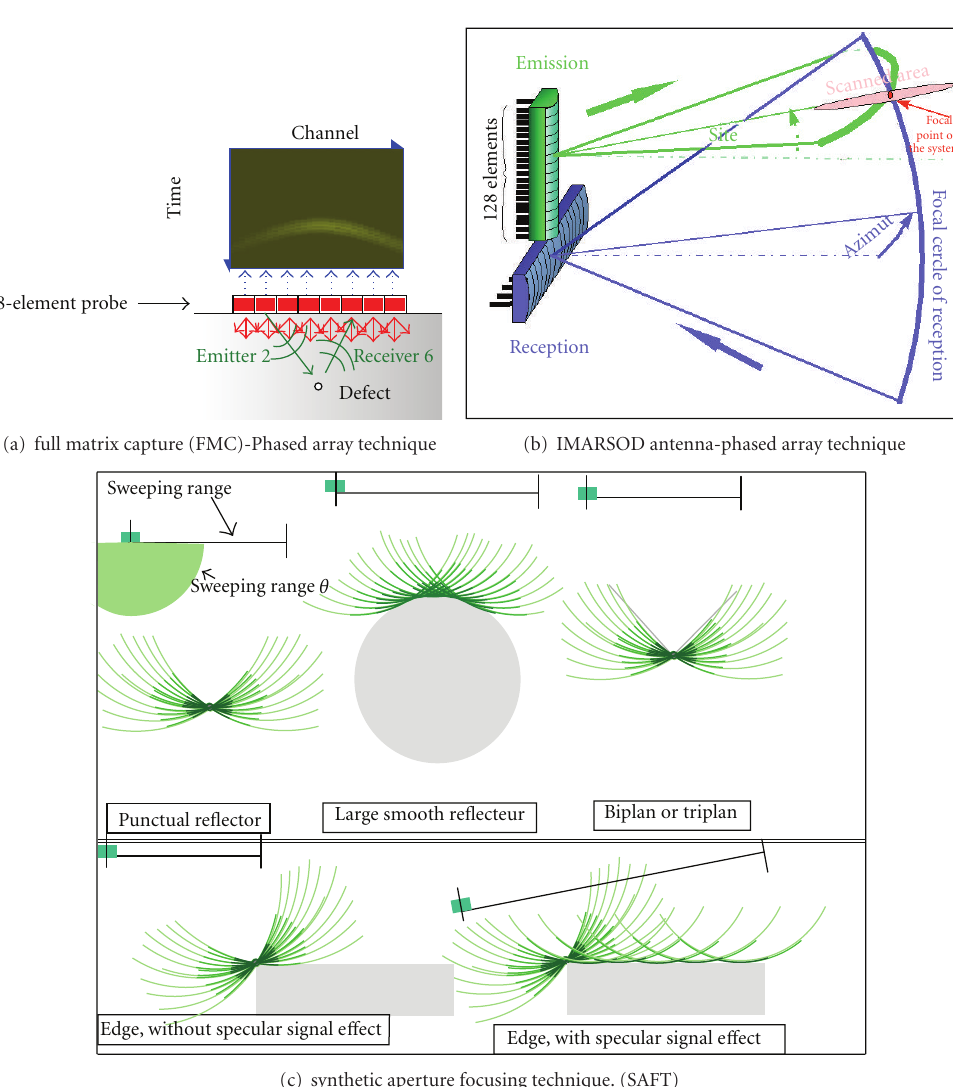
Figure 19: Ultrasonic visualization techniques